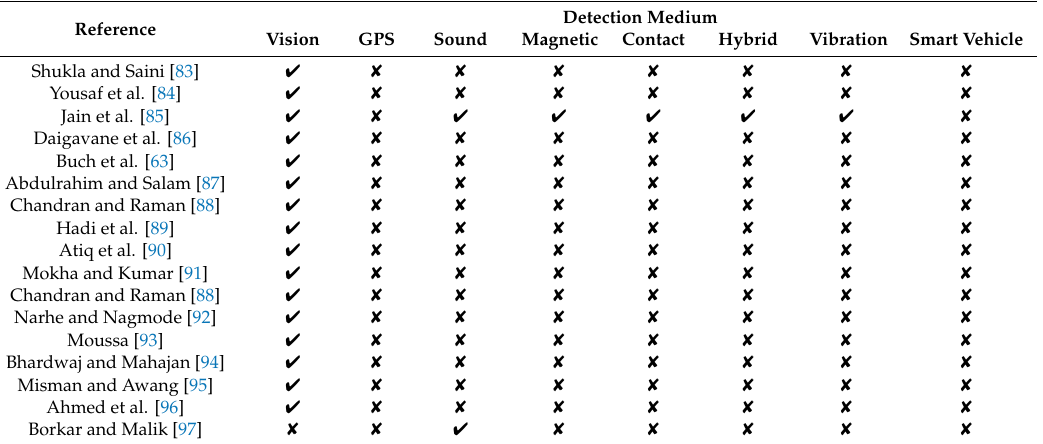
Table 3. Summary of the literature reviews on